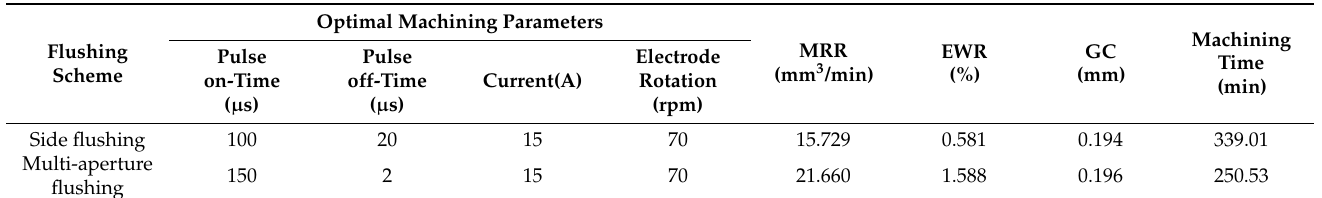
Table 13. Optimal conditions and machining performance of EDM with side and multi-aperture flushing.